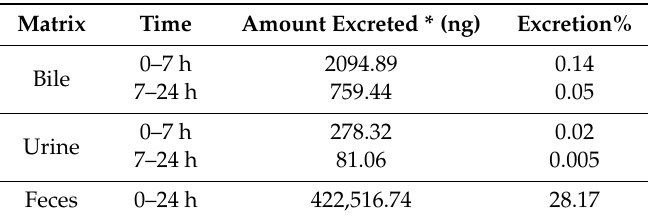
Table 8. Percentage of administered dose of SCH 58261 excreted in bile, urine, and feces following oral administration of 5 mg / kg in the rat. Matrix